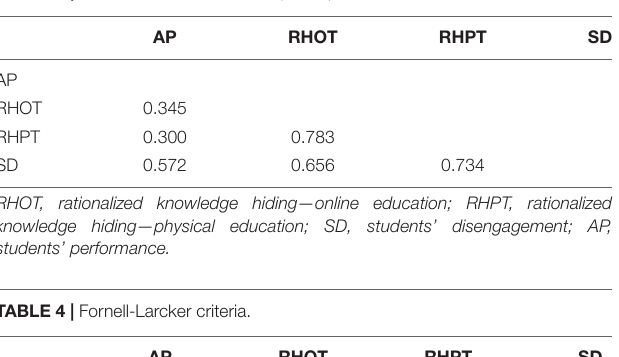
TABLE 3 | Heterotrait-monotrait ratio (HTMT) ratio.